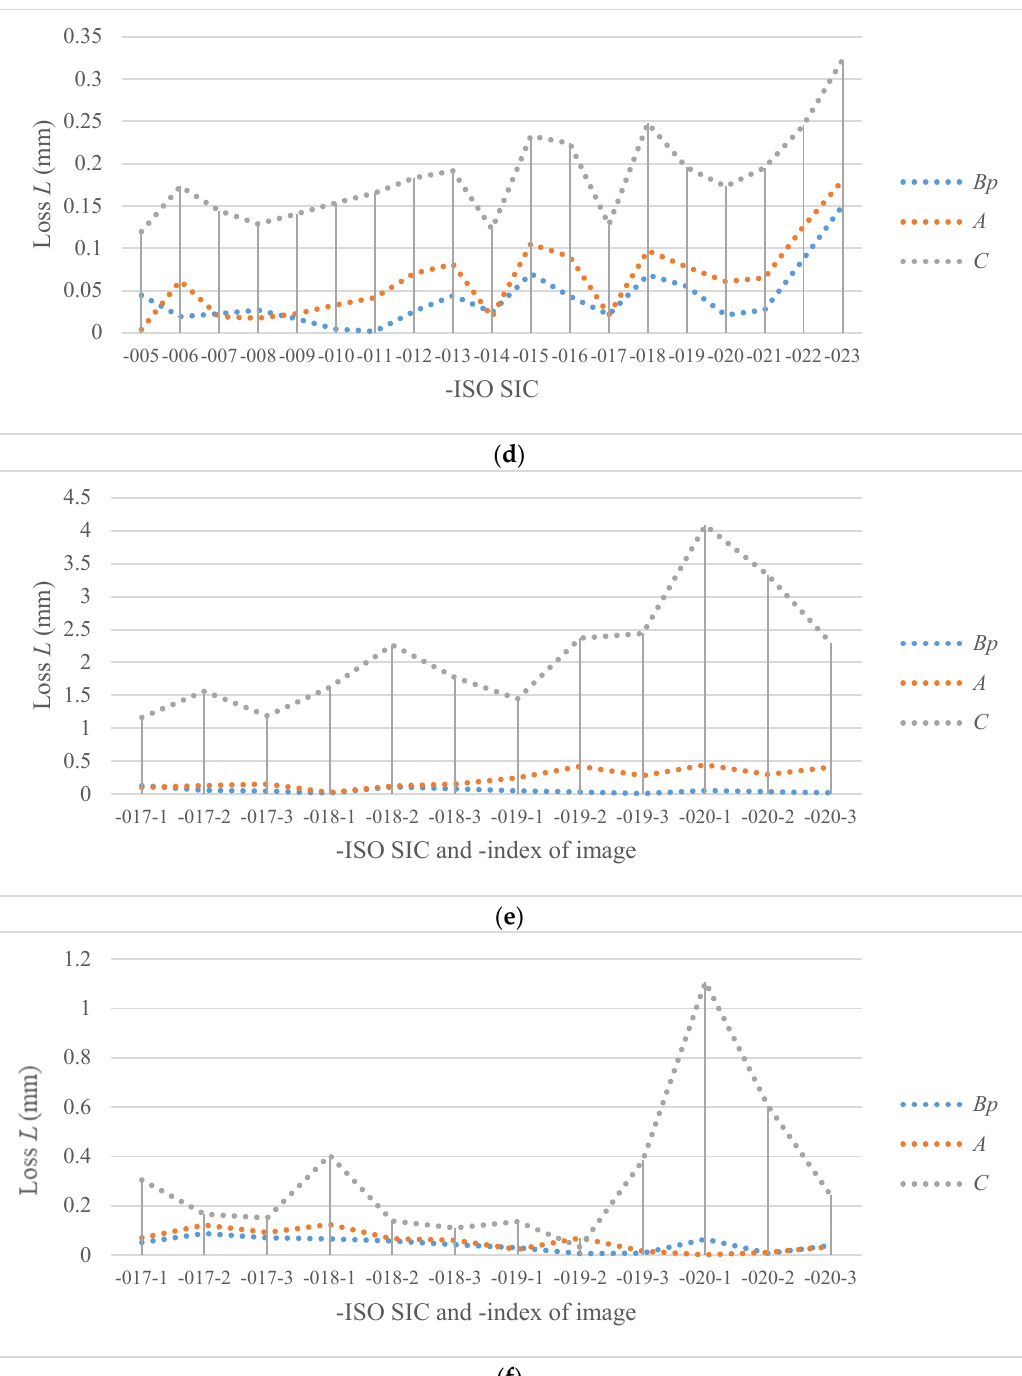
Figure 26. ( a ) Result of d 1 measurement with DVT; ( b ) result of d 2 measurement with DVT; ( c ) result of d 1 measurement with DSI; ( d ) result of d 2 measurement with DSI; ( e ) result of d 1 measurement with DSP; ( f ) result of d 2 measurement with DSP.